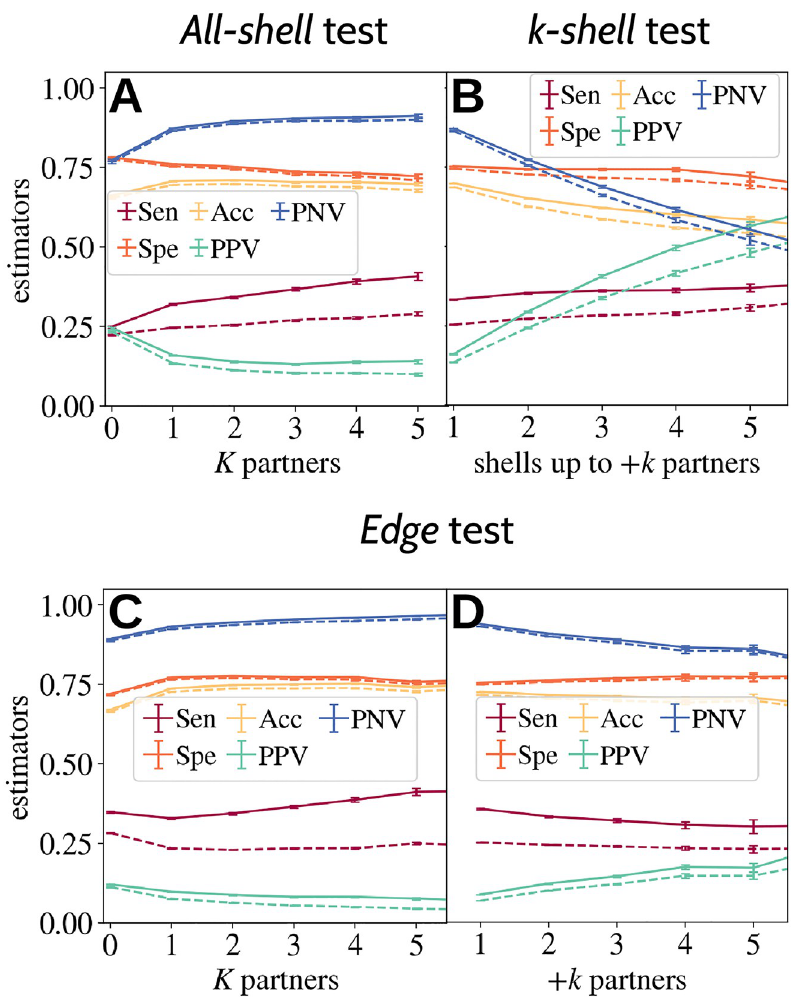
Fig 3. Average sensitivity (Sen), specificity (Spe), accuracy (Acc), positive predictive value (PPV) and negative predictive value (NPV) of predictions based on knowledge of soft disorder in a parent. A. The all-shell prediction quality is evaluated as a function of K , the number of partners of the parent node. B. The k-shell predictions is evaluated as a function of k , the maximum depth (in terms of new partners) of the shell used to compute the union of the interfaces. C, D. The goodness of the prediction of the edge test is evaluated either as a function of the parent K or as a function of + k , the number of new partners, of the direct offspring. In all tests, solid lines refer to the actual test and dotted lines to the random guess